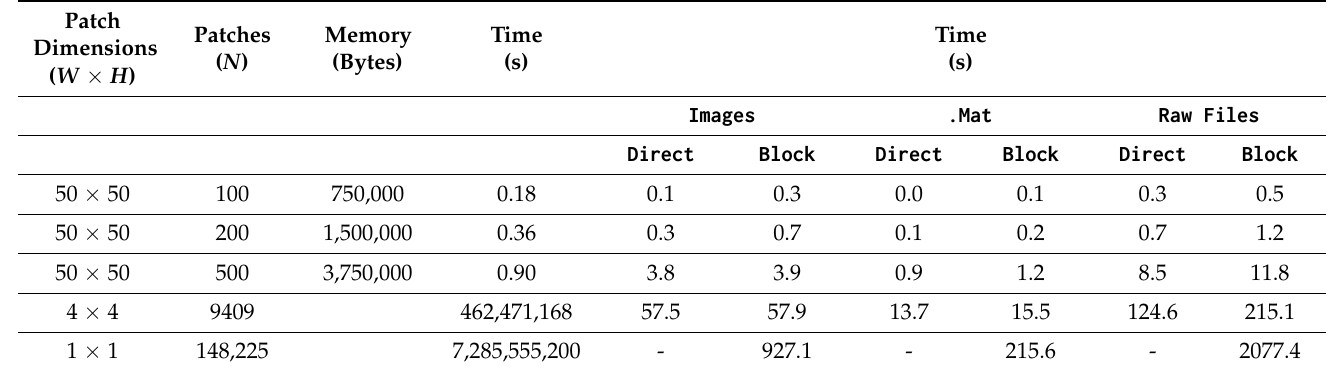
Table 6. Time and memory requirements regarding an RGB color image with dimensions of 512 × 512 pixels and patch size set to 128 × 128